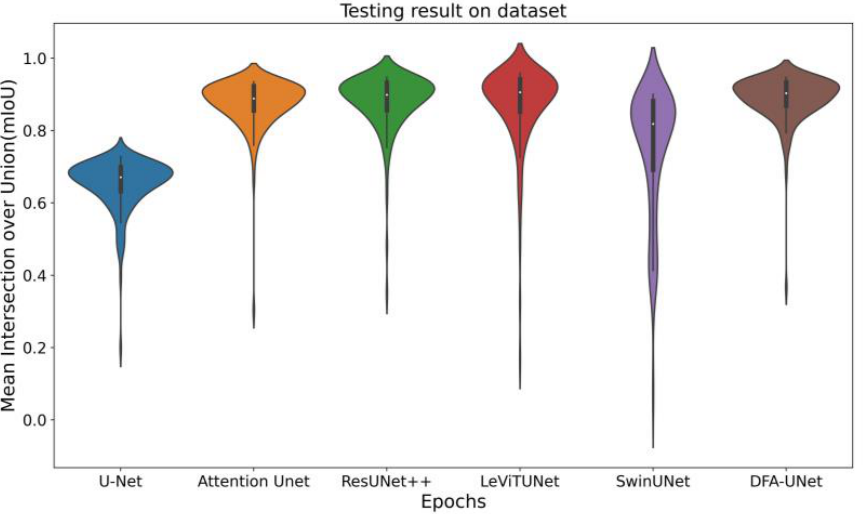
Figure 4. MIoU performance on different models .